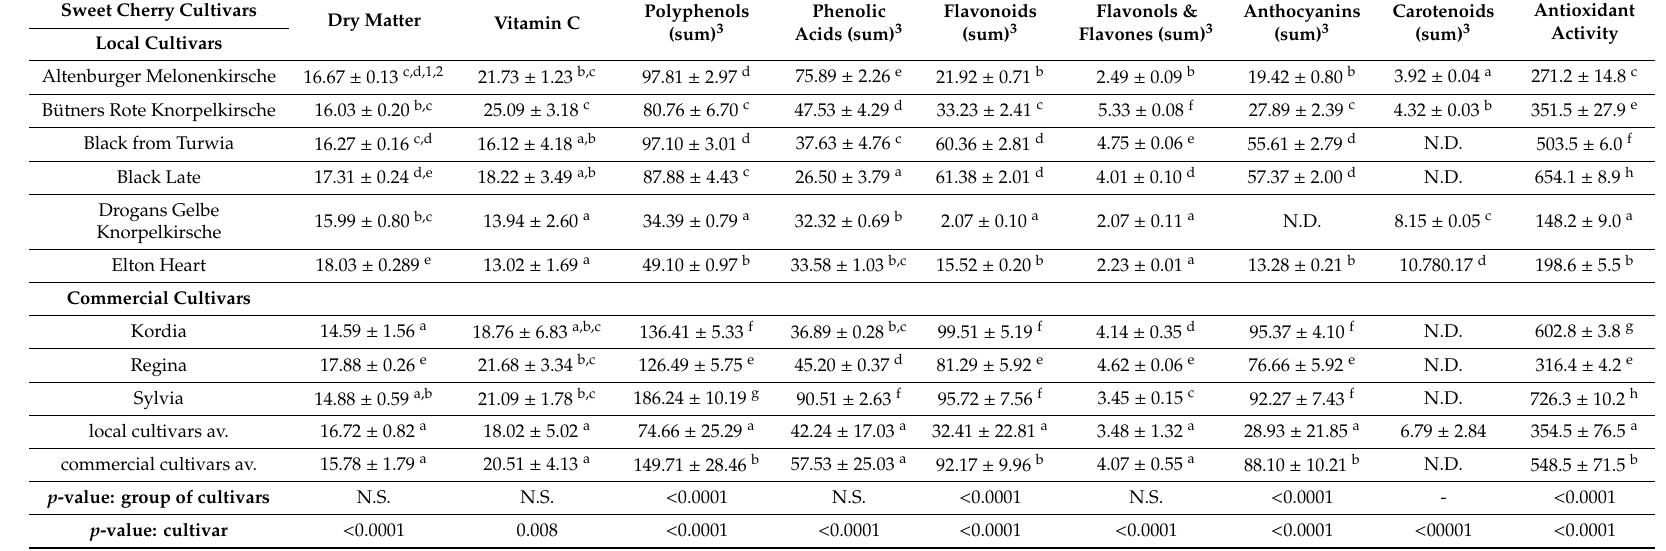
Table 4. The content of dry matter (in g 100 g − 1 FW), vitamin C, polyphenols, carotenoids (in mg 100 g − 1 FW), and antioxidant activity (mmol Trolox 100 g − 1 FW) in sweet cherry fruit harvested in